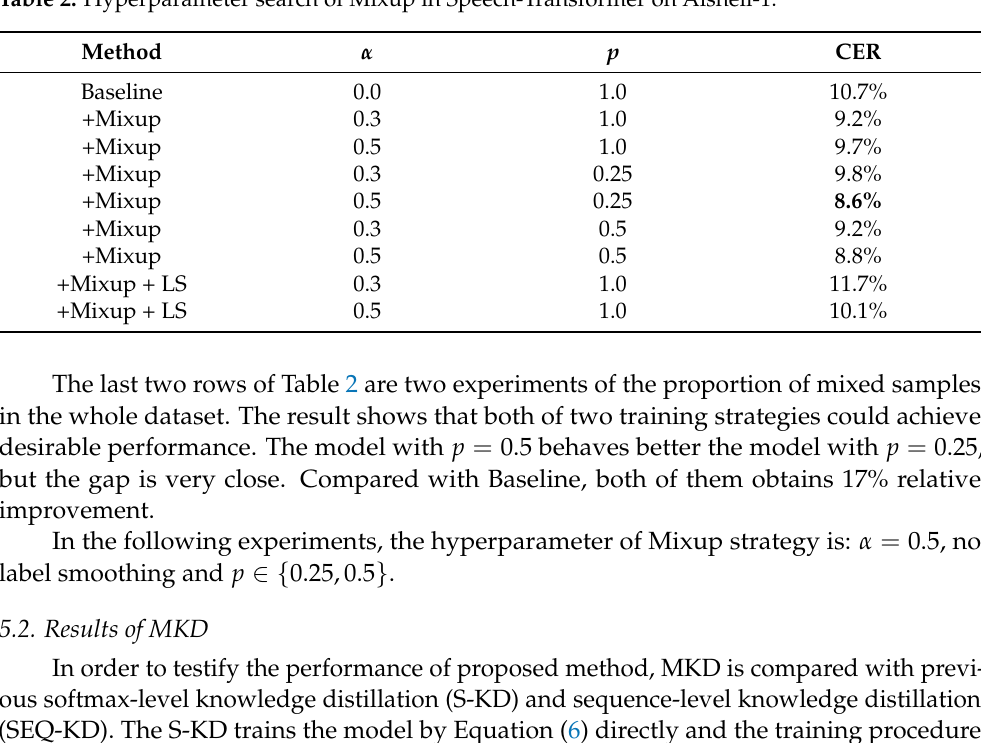
Table 2. Hyperparameter search of Mixup in Speech-Transformer on